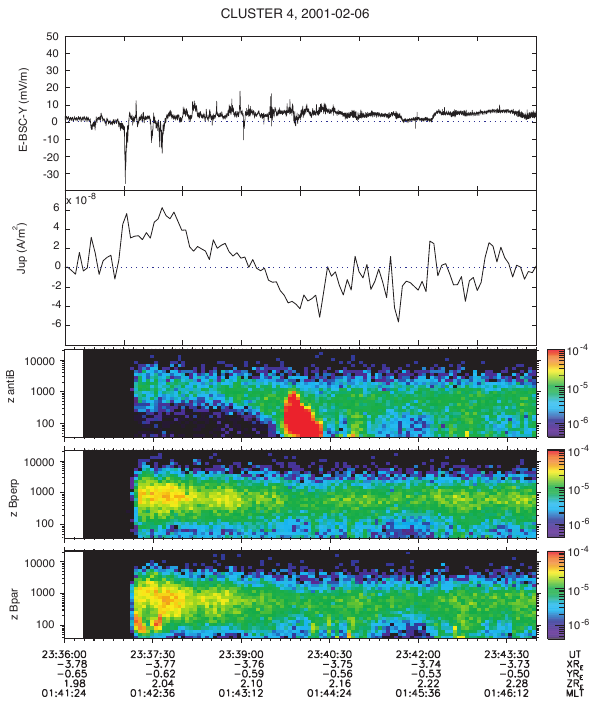
Fig. 12. As Fig. 11, but for C4.